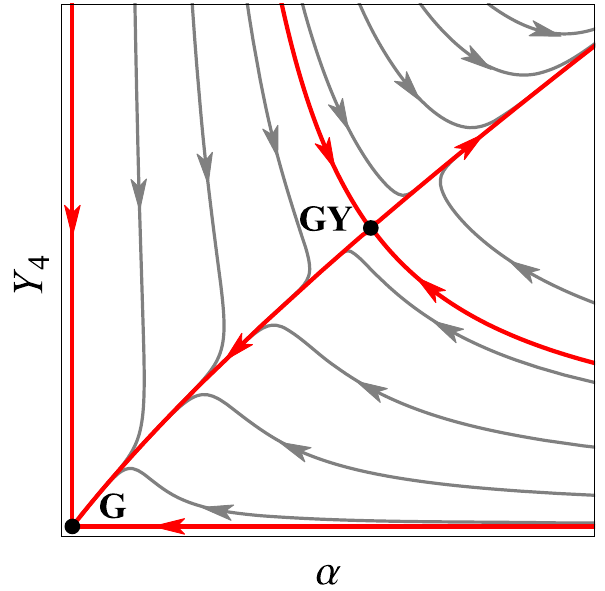
Fig. 5 Fixed points and phase diagrams of gauge–Yukawa theories with B < 0 and C (cid:16) < 0 at weak coupling showing asymptotic safety together with the Gaussian and gauge–Yukawa fixed points. Notice that the set of UV finite trajectories is confined to a hypercritical surface dictated by the Yukawa